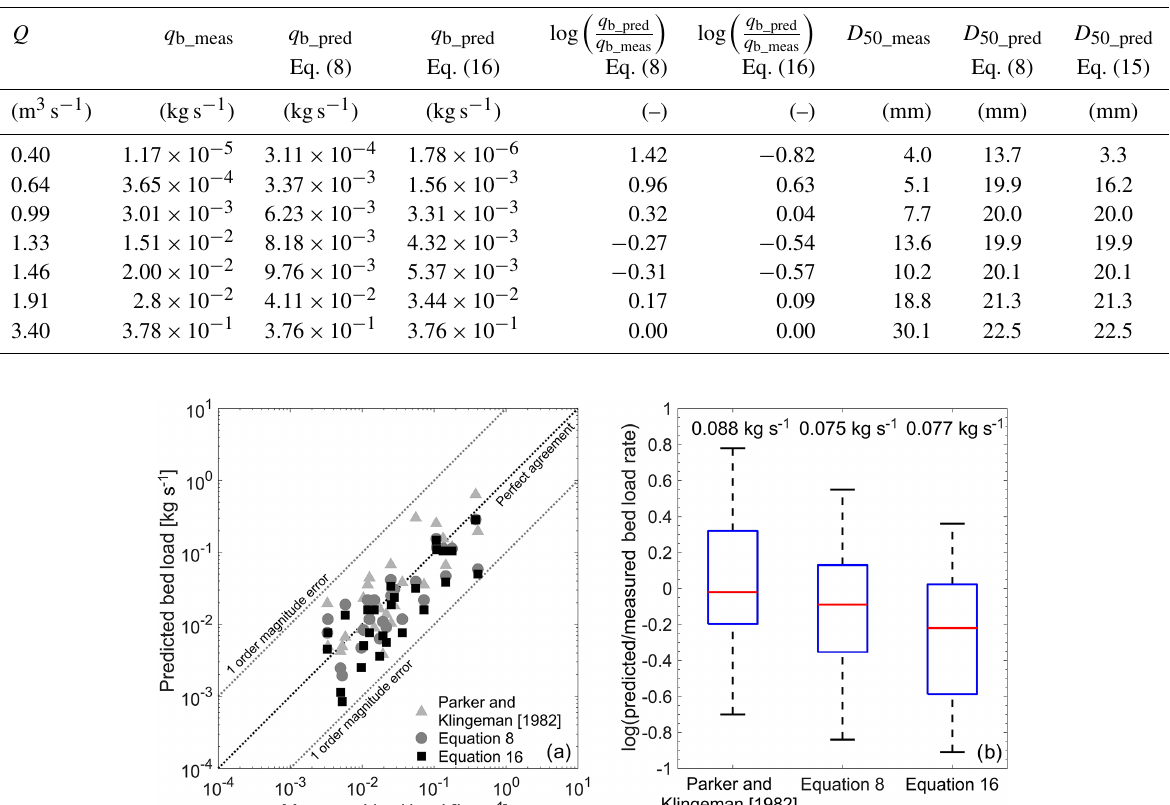
Table 3. Bed load transport rates ( q b ) and median grain size estimates ( D 50 ) using Eqs. (8) and (16).